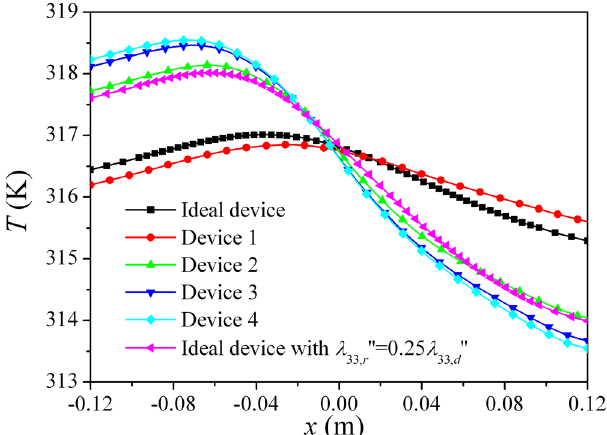
Figure 6. The temperature profile along x -axis on the top surface of the system. λ 33, r ″ and λ 33, d ″ represent the decreased and the originally designed minimum components of thermal conductivity tensor, respectively. Therefore, to achieve good effect of camouflage, good process accuracy and low ITR values are required in the construction process for the